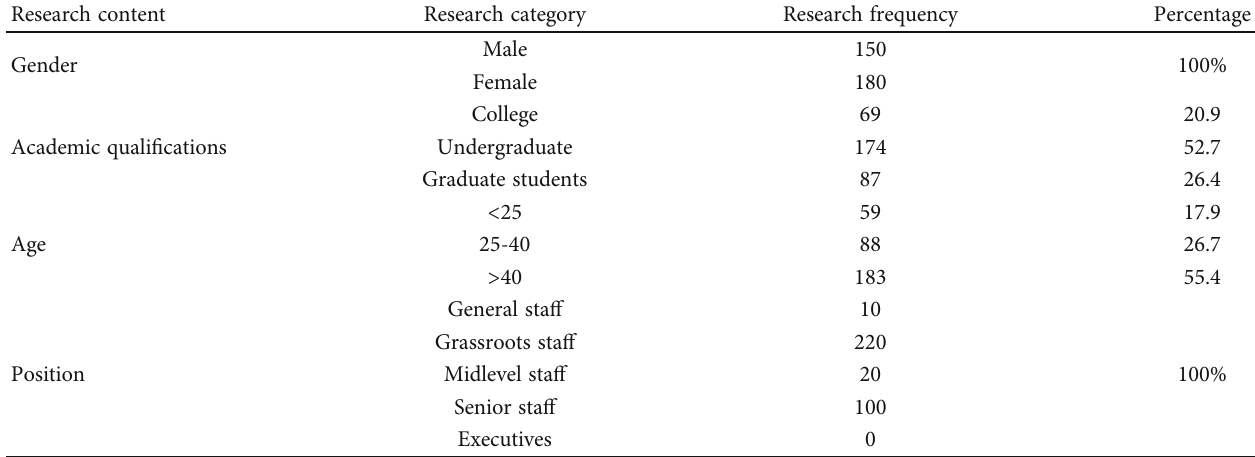
Table 1: Descriptive statistics of the basic conditions of the survey